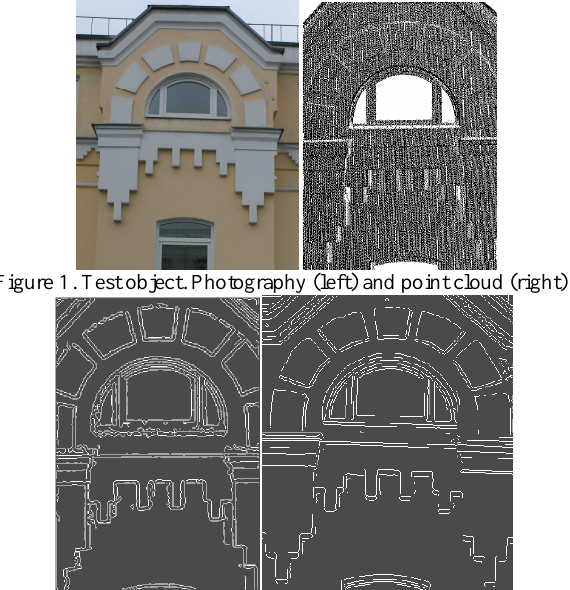
Figure 2. Extracted edges. Quasi image (left) and photography (right).